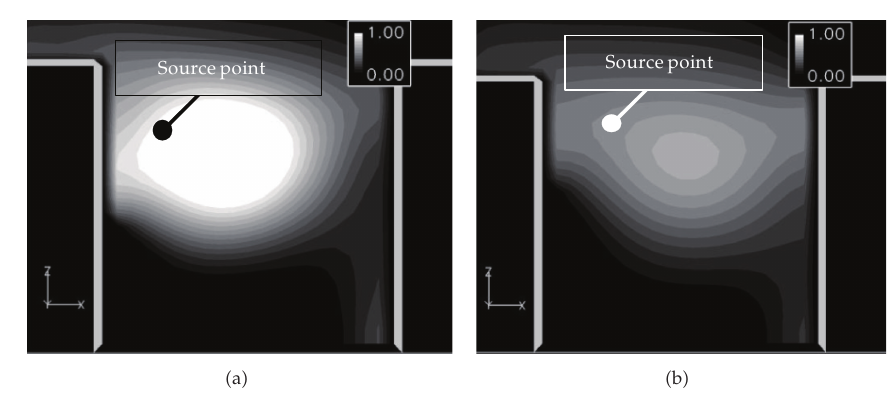
Figure 7: Reverse analysis results (cid:3) tU b /H b (cid:7) 200 (cid:4) : (cid:3) a (cid:4) Case 3-2 and (cid:3) b (cid:4) Case 3-3.